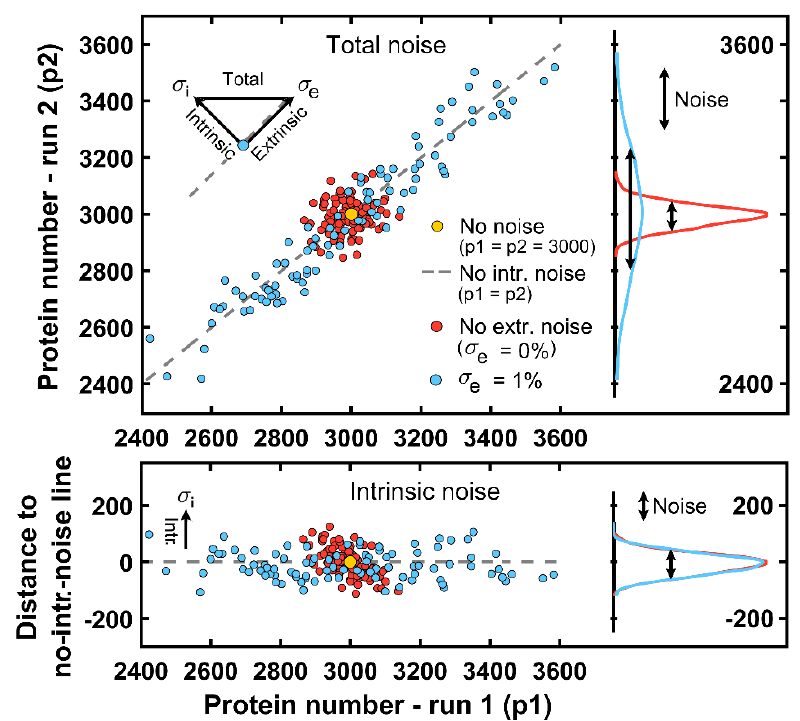
Figure 7. E ff ect of intrinsic and extrinsic noises in the protein amount of R 1 under steady-state Figure 7. Effect of intrinsic and extrinsic noises in the protein amount of R 1 under steady-state conditions with a signal presence for Ω equal to 10. Two groups of 100 cells each were simulated with conditions with a signal presence for equal to 10. Two groups of 100 cells each were simulated with 2 runs per cell with a mean value of k syn / k deg · Ω = 3000 in both cases. In particular, a cellular group 2 runs per cell with a mean value of = 3000 in both cases. In particular, a cellular group Ω without extrinsic noise (red dots) and another with σ e = 30 (blue dots, 1% of the mean value) were without extrinsic noise (red dots) and another with = 30 (blue dots, 1% of the mean value) were 𝑘𝑘 𝑠𝑠𝑠𝑠𝑠𝑠 / 𝑘𝑘 𝑑𝑑𝑑𝑑𝑑𝑑 · Ω simulated. The bottom panel depicts the intrinsic component σ i of the total noise. The intrinsic noise simulated. The bottom panel depicts the intrinsic component of the total noise. The intrinsic noise σ 𝑑𝑑 is given by the di ff erence in protein number with respect to the gray line, i.e., the no-intrinsic-noise is given by the difference in protein number with respect to the gray line, i.e., the no-intrinsic-noise σ 𝑑𝑑 line. The probability density function of the total (top panel) and the intrinsic (bottom panel) noises is line. The probability density function of the total (top panel) and the intrinsic (bottom panel) noises shown on the right is shown on the right side.